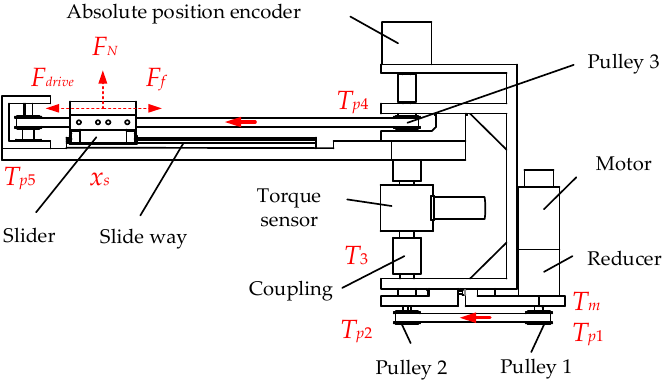
Figure 11. The dynamics of the flexion/extension motion module from the motor to the slider.